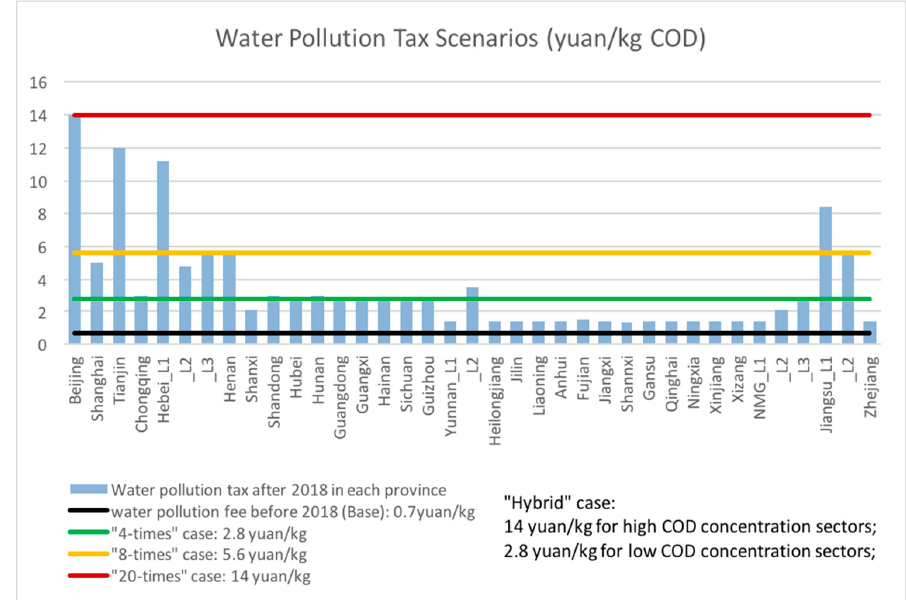
Figure 1. Four water pollution tax policy scenarios of China. Here the high discharge sectors are Coal mining; Oil mining; Natural gas mining; Non-energy mining; Food products and tobacco processing; Textile goods; Wearing apparel, leather, furs, down and related products; Paper and products, printing and record medium